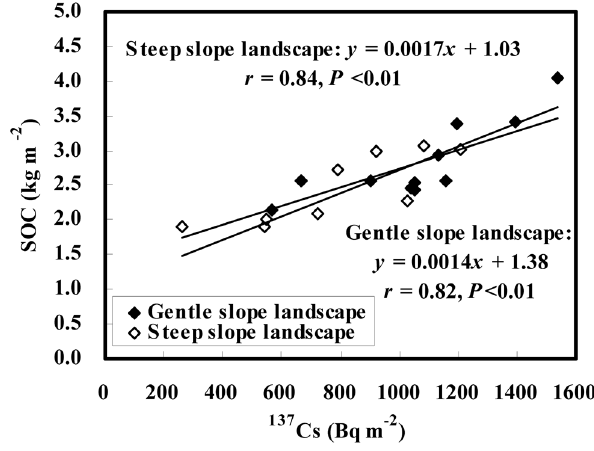
Figure 3. Distribution of SOC and MBC contents over eroded slopes. (a) gentle slope landscape; (b) steep slope landscape.